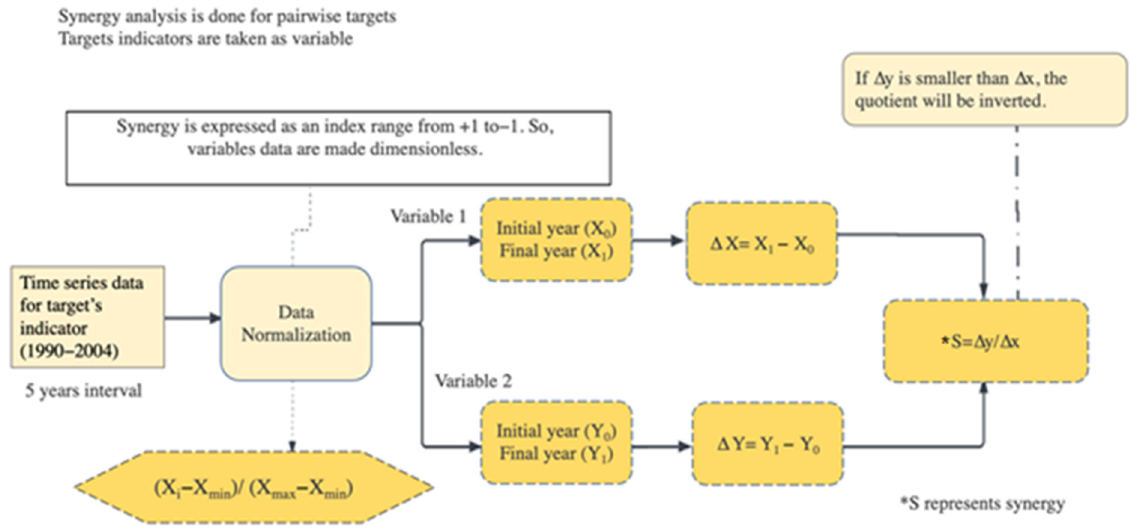
Figure 4. Description to evaluate the synergy and trade-offs between SDGs.